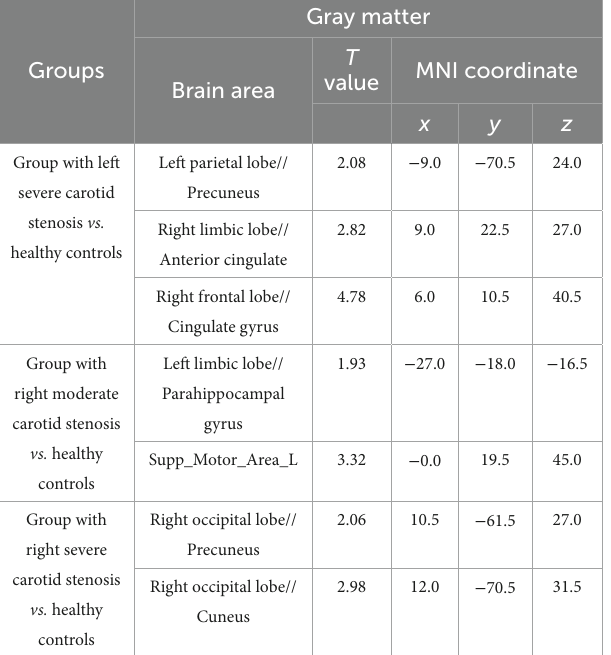
TABLE 8 Voxel-based morphometry (VBM) analysis of the declined gray matter volume in patients with carotid artery stenosis compared with healthy